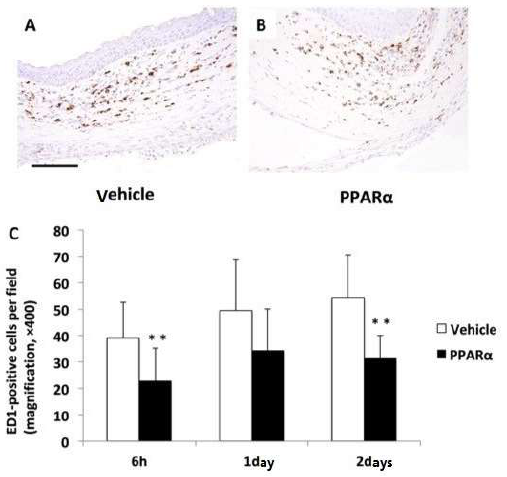
Figure 5. Infiltration of macrophages in alkali-burned cornea. The number of infiltrating ED1-positive macrophages ( C ) was significantly lower in the PPARα agonist group ( B ) than the vehicle group ( A ) at 6 h and on day 2 (** p < 0.01). Scale bar: 50 μm.